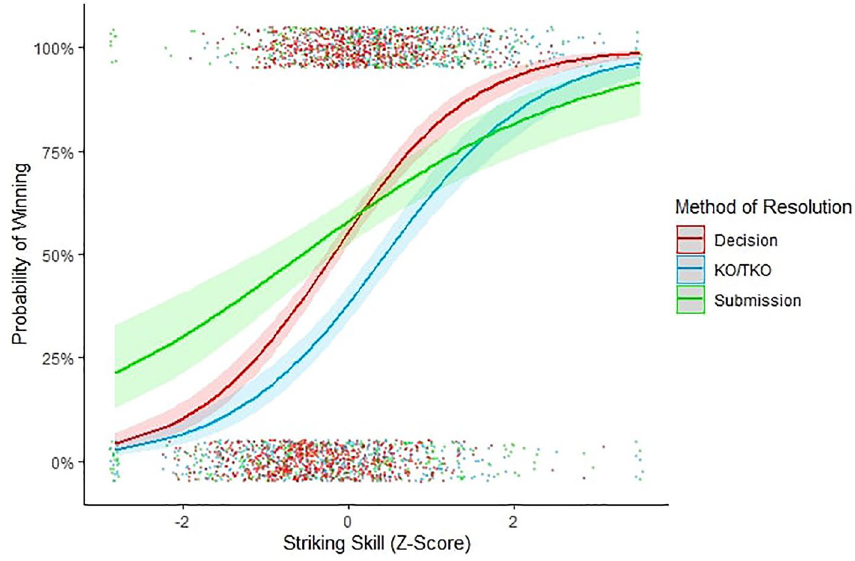
Figure 1. Interaction between striking skill and method of resolution on likelihood of winning. Error bands illustrate 95% confidence intervals. Data points are jittered for visibility purposes.